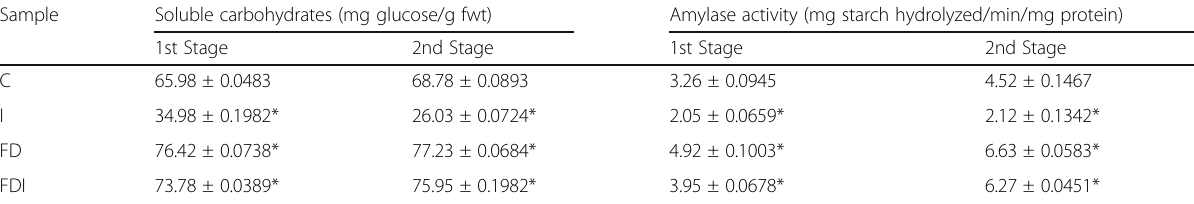
Table 2 Effect of defensin priming on carbohydrates hydrolysis (soluble carbohydrates and amylase activity) in plants under Fusarium infection Sample